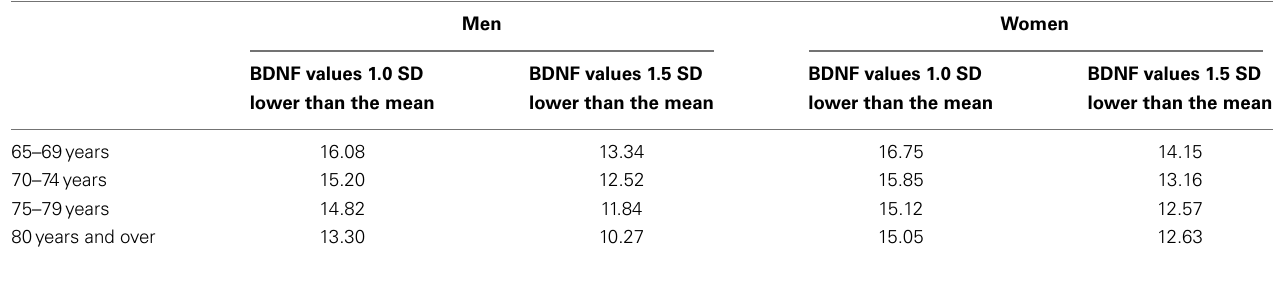
Table 1 | Serum BDNF levels among the four age-groups